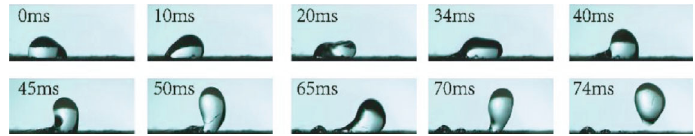
Figure 17: The movement of 6 μ L droplet on GDL surface under the interaction of vertical vibration and air fl ow.